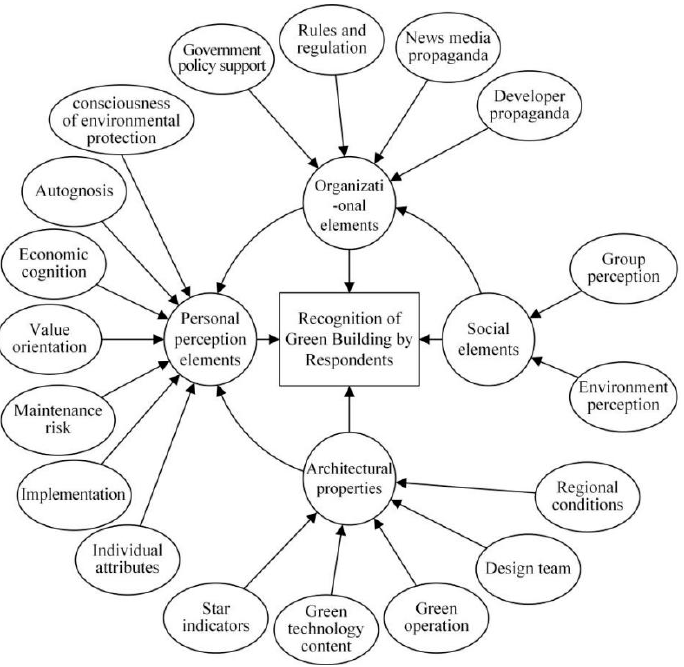
Figure 2. Theoretical construction of factors influencing the development of green building.